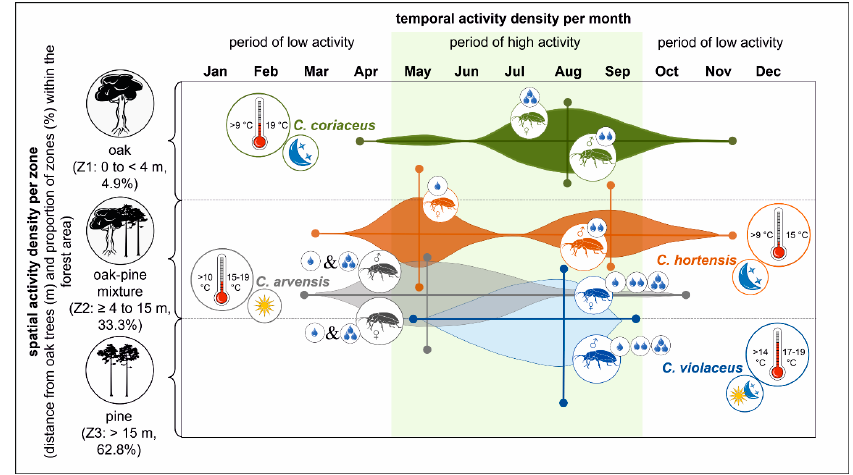
Figure 7. Schematic summary of the results to show potential niche partitioning and coexistence within a framework of temporal and spatial information for C. coriaceus , C. violaceus , C. hortensis and C. arvensis explained by tree species effects (oak and pine) (legend: coloured areas indicate species-specific temporal and spatial activity densities including distribution tendencies; the size of the female and male carabid symbols represents their proportions; the position of the female and male symbols shows their relation to spatial zones; mean monthly precipitation level: one drop—low, two drops— moderate, three drops—high; temperature: left side—onset of beetle activity at mean monthly temperatures, right side—highest densities at mean monthly temperatures [°C]; characterisation of main beetle activity during the course of the day: sun—diurnal, moon—nocturnal, sun and moon—twilight, according to [39,88].